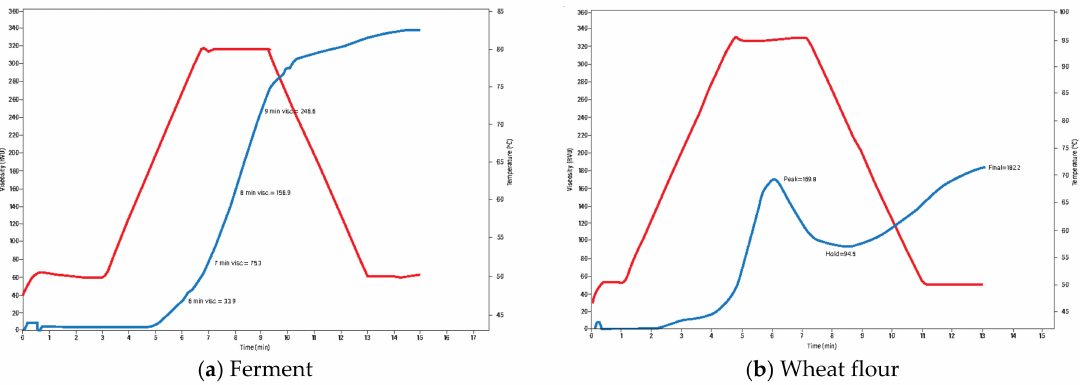
Figure 2. RVA pasting curves of the ferment ( a ) and wheat flour ( b ) (RVU—rapid visco